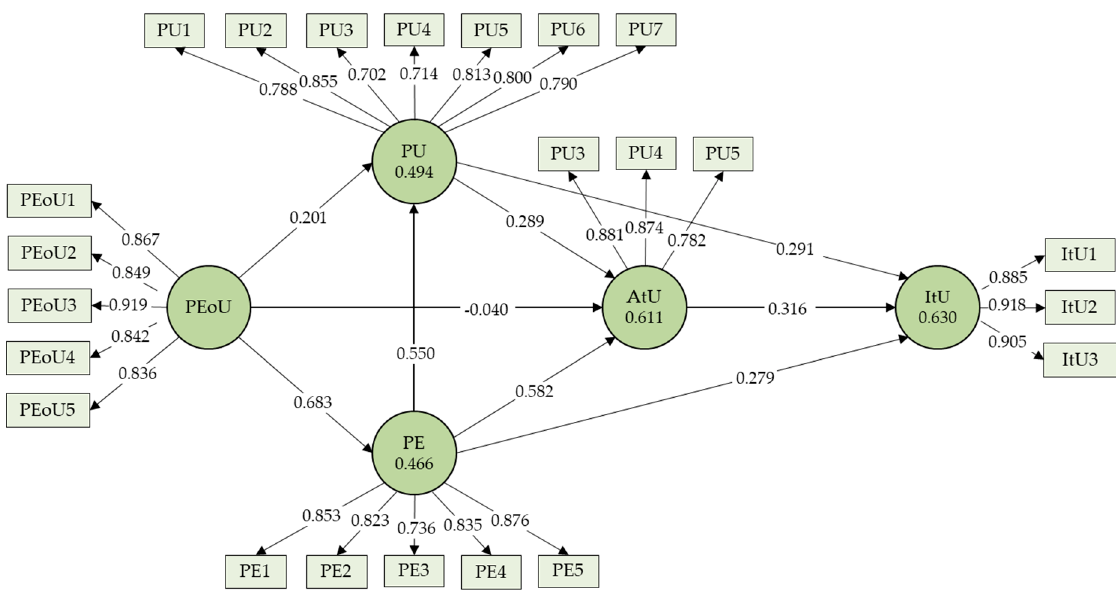
Figure 10. Structural equation model.